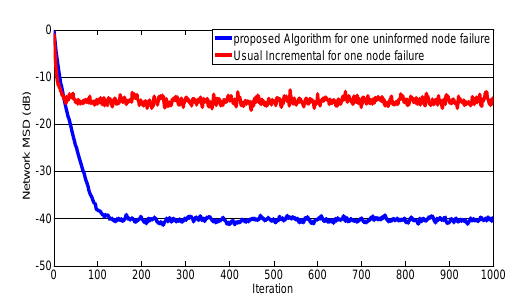
Figure 10. Transient network MSD for usual (red) and proposed (blue) incremental LMS for first uninformed node failure.